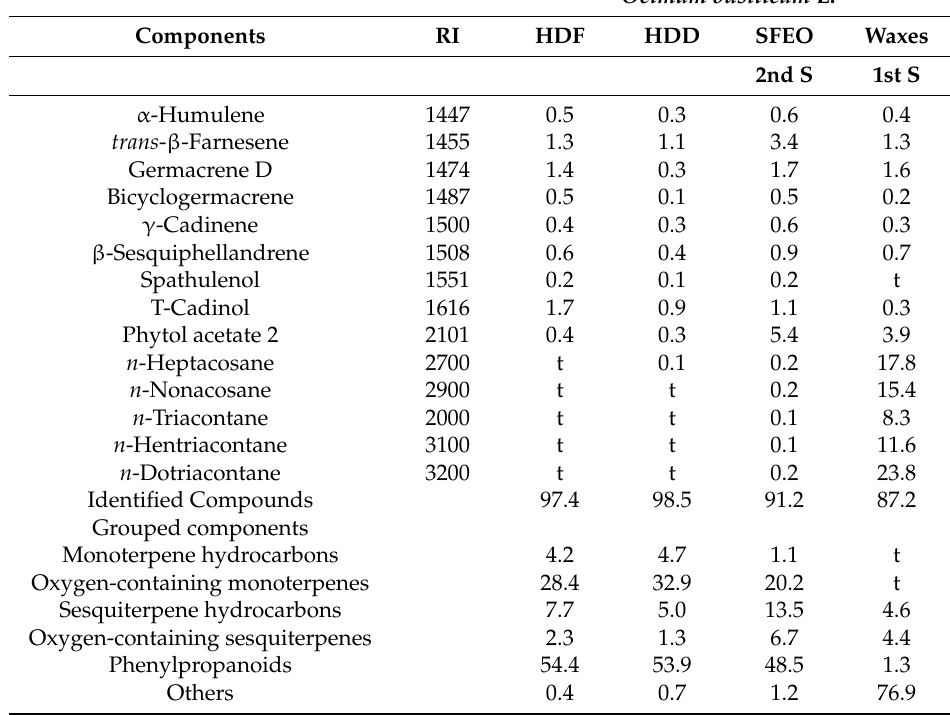
Ocimum basilicum L.